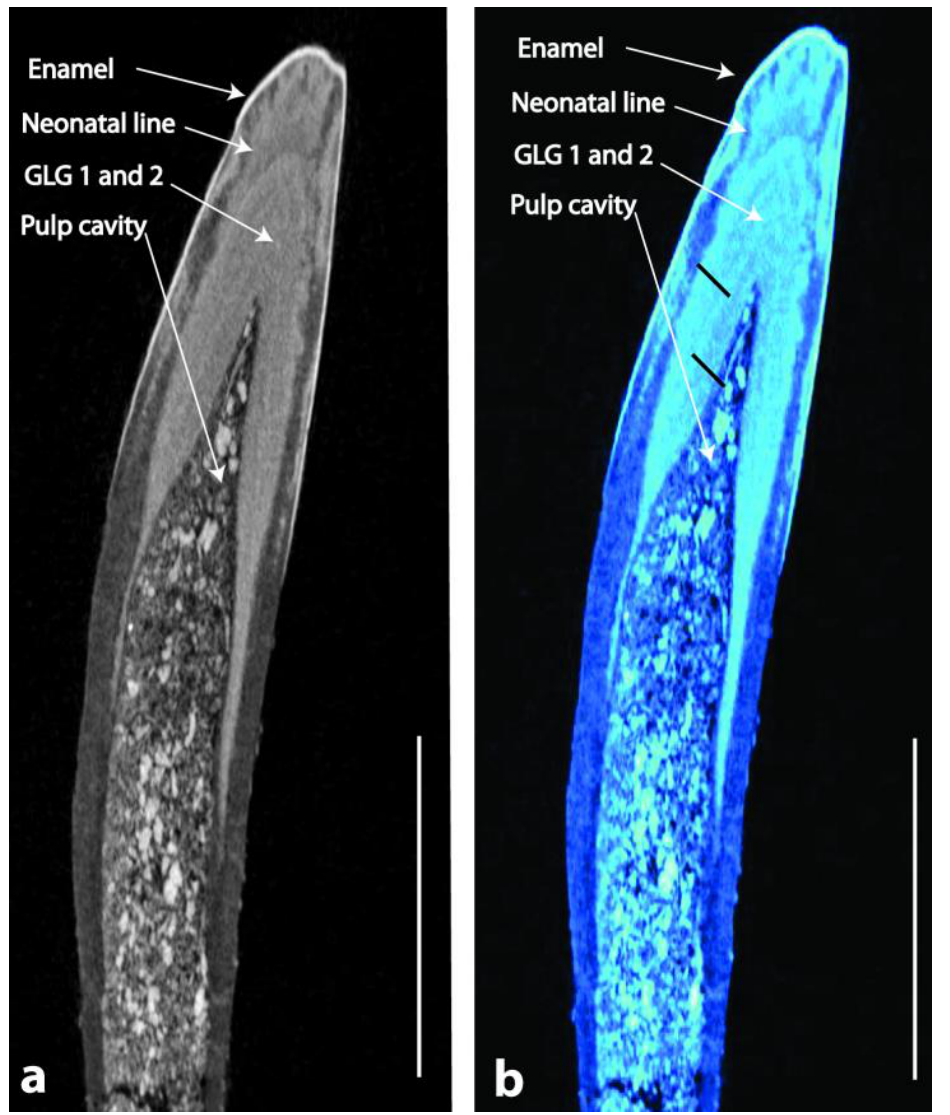
Fig. 4. Internal structure of fossil unnamed Delphinoidea tooth (OU 22108) finely resolved by Micro-CT. Scale bar = 5 mm. a) Orthogonal view of the specimen. b) Same specimen after colorizing treatment to enhance